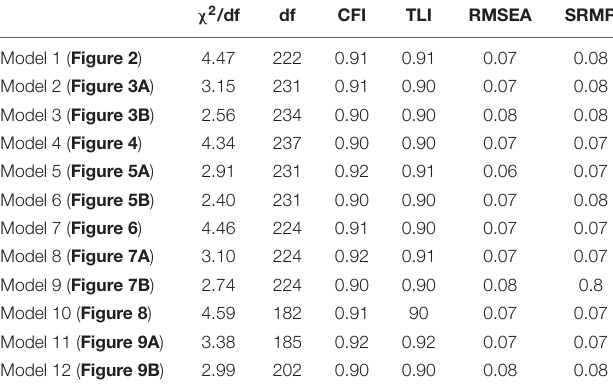
TABLE 3 | Goodness of Fit Indices for the Models.